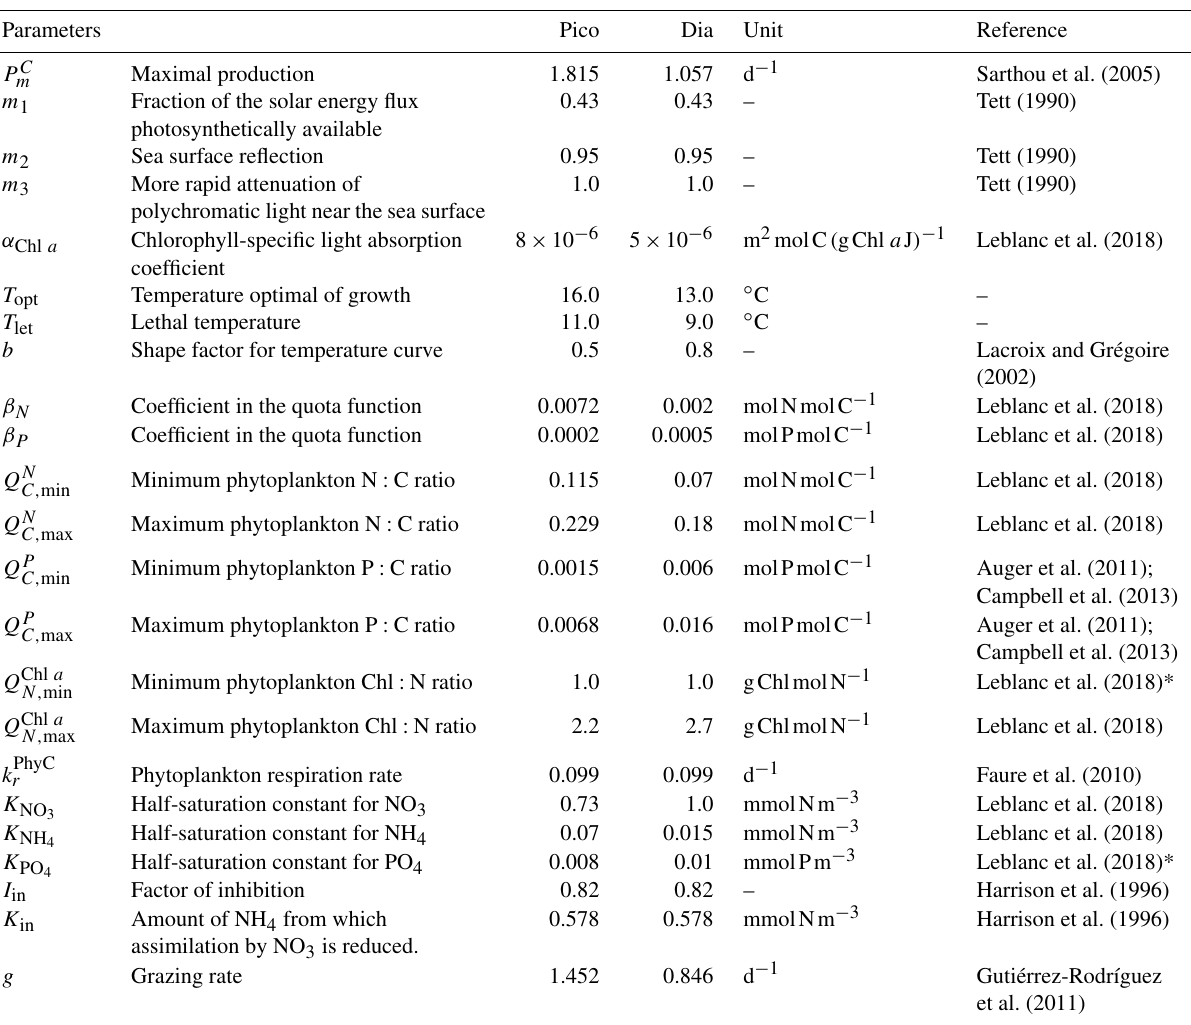
Table B4. Value of